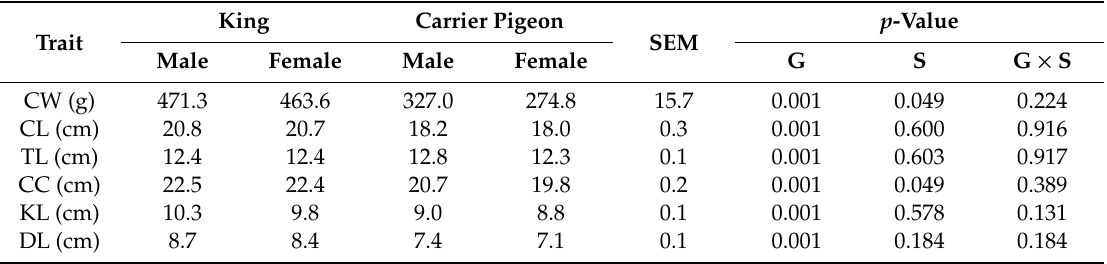
Table 1. Carcass weight and measurements in three-year-old pigeons of di ff erent genotypes. King Carrier Pigeon Trait